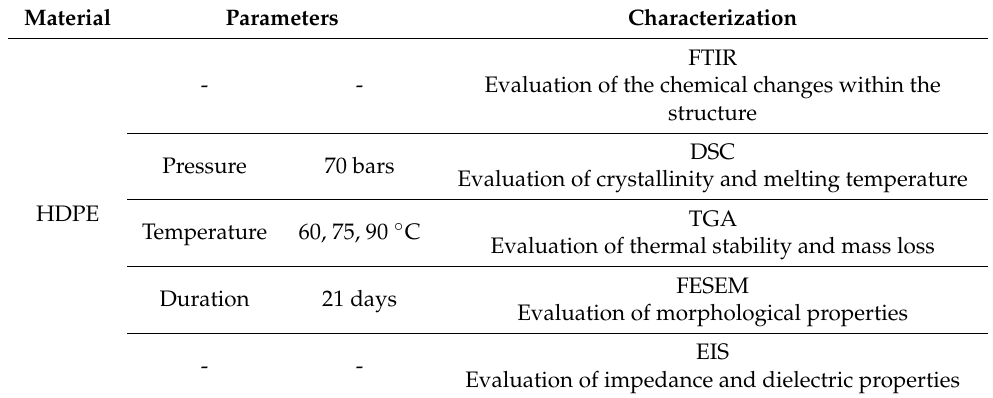
Table 3. Experimental Design